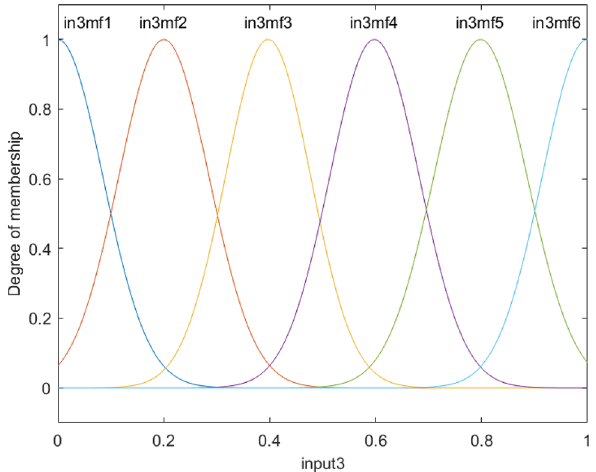
Figure 12. Degree of membership function, and the function performance as a function of the third input for six membership functions for each input parameter.